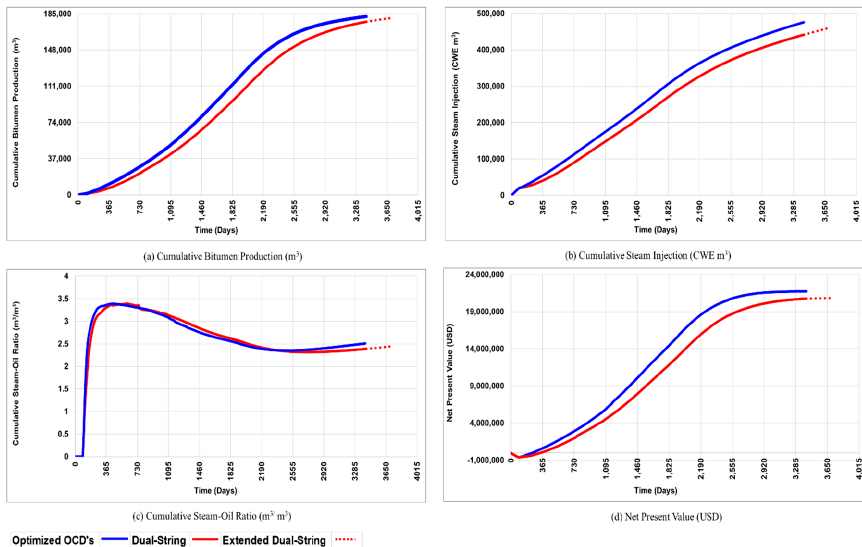
Figure 15. SAGD performance data of optimized OCDs and dual ‐ string cases.